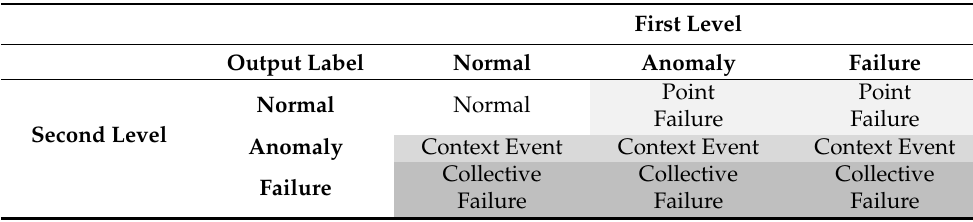
Table 1. Output fault/outlier type (cell background colors help identify outlier types).